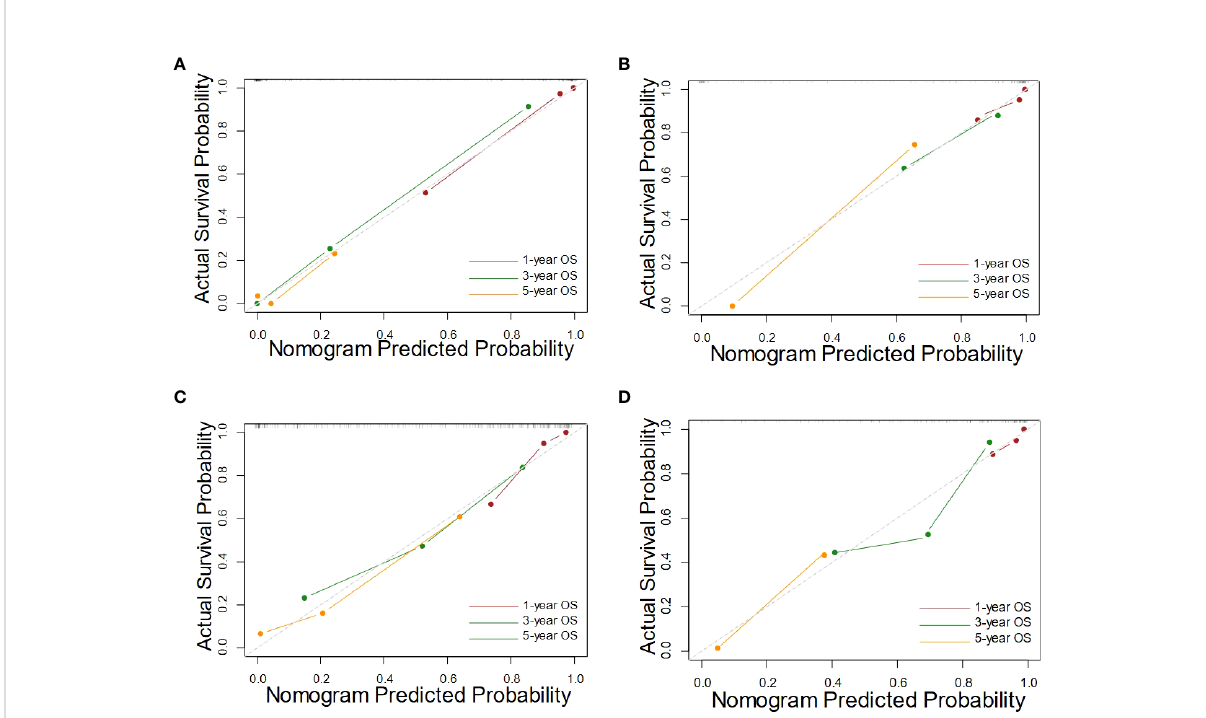
FIGURE 4 The calibration curves of the integrated nomograms in training cohort (A) and the validation cohort (B) , along with the clinical nomograms in training cohort (C) and the validation cohort (D) .